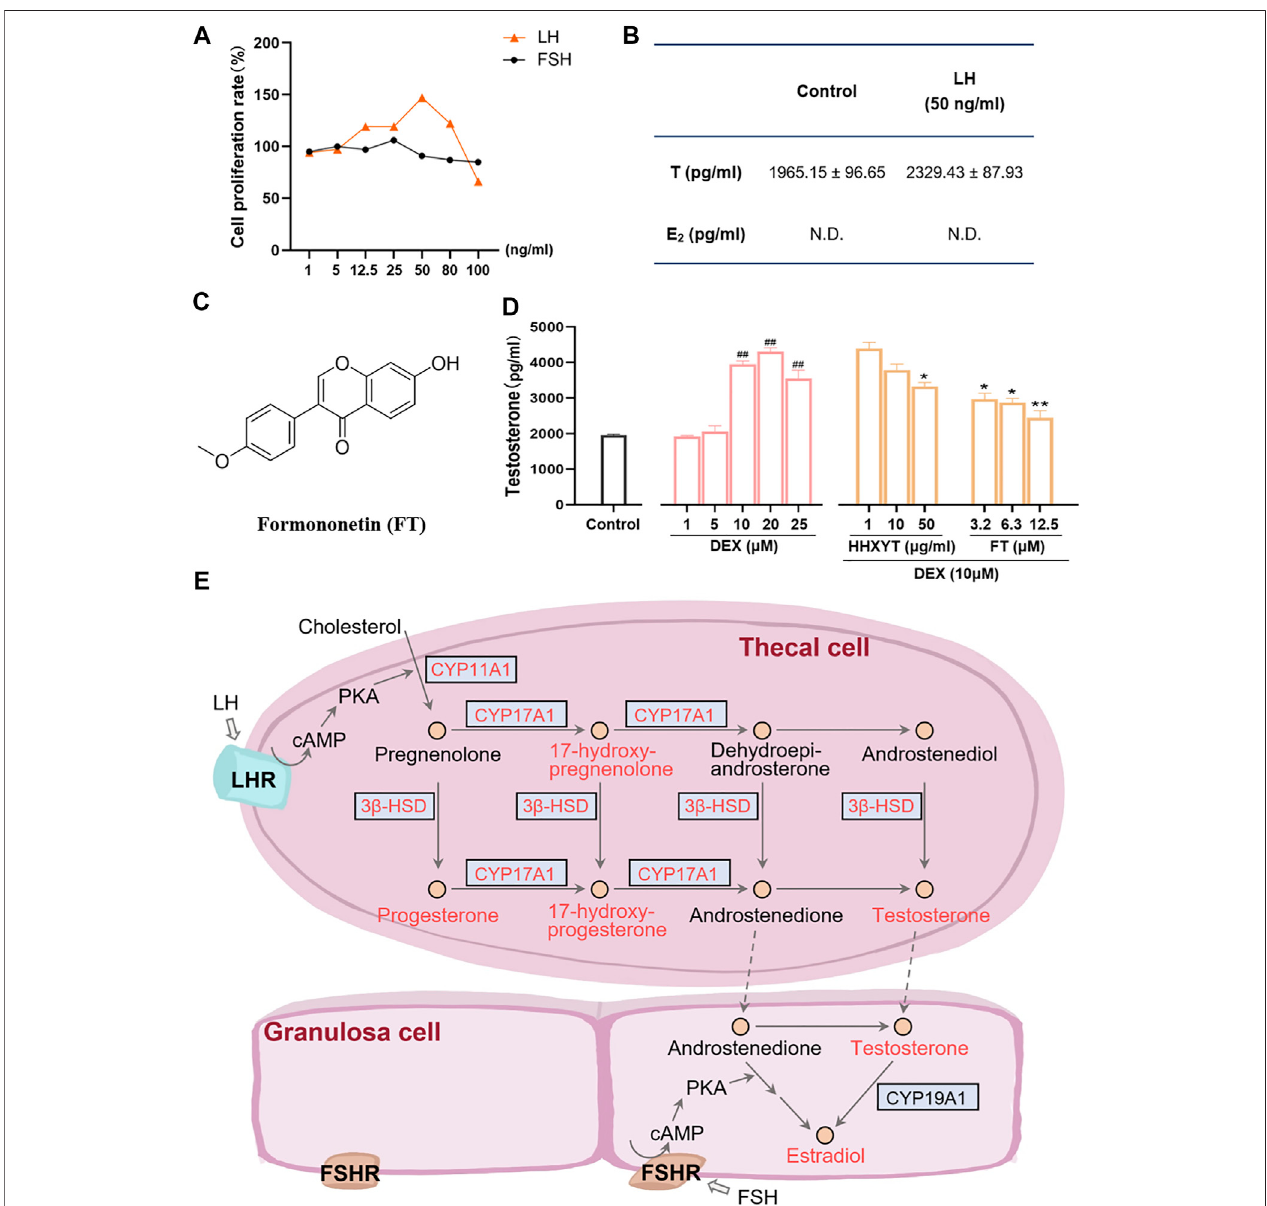
FIGURE 9 | Cell-based assay to evaluate the HHXYT ’ s effects on testosterone synthesis in thecal cells. (A) The proliferation effect of luteinizing hormone (LH) and follicle-stimulating hormone (FSH) on thecal cells. (B) Effects of LH on the production of testosterone (T) and estradiol (E 2 ) in thecal cells. (C) The chemical structures of formononetin (FT). (D) Effects of dexamethasone (DEX), HHXYT, and FT on the production of testosterone by thecal cell. n = 4, ## p < 0.01, to the Control group; * p < 0.05,** p < 0.01,comparedtotheDEX(10 µM)group. (E) Pathwaysforthesynthesisoftestosteroneandestradiolbythecalcellsandgranulosacellsinfollicles.The compounds and targets involved in this study were marked by orange-red